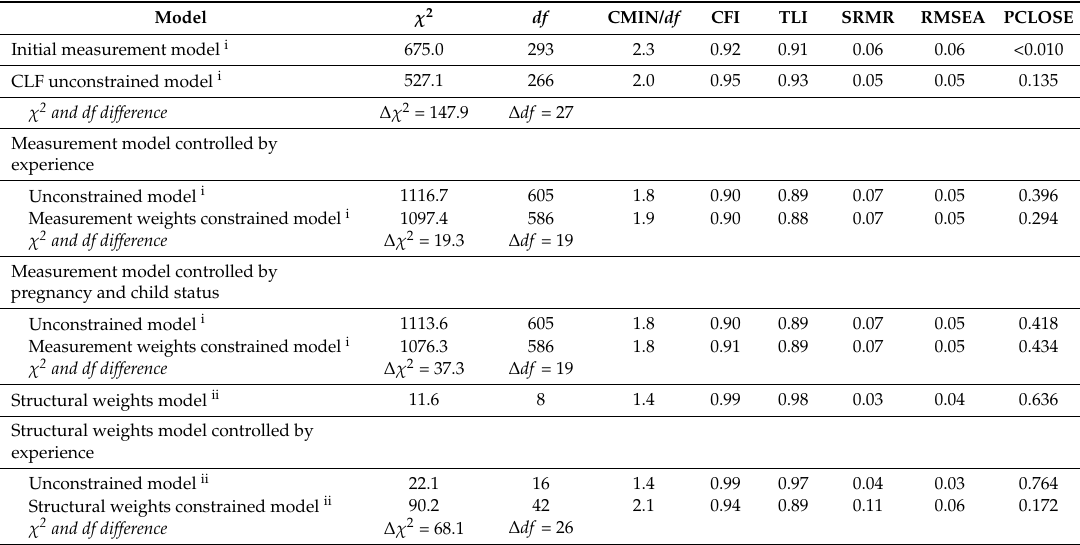
Table 2. Model fit indices ( i n = 331; ii n = 328). Model χ